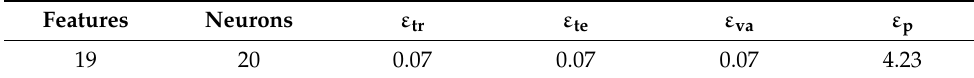
Table 3. Selected model results.